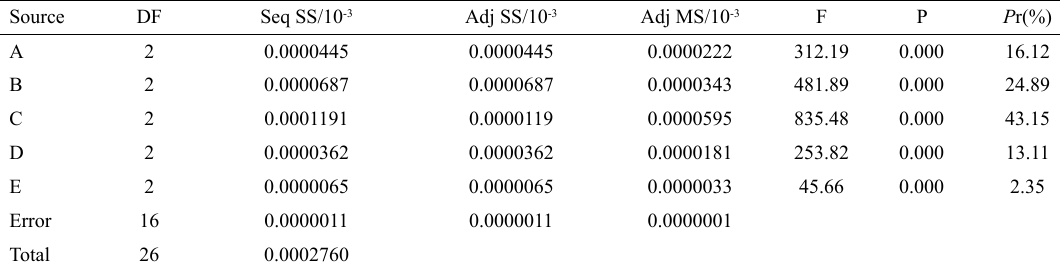
Table 7. ANOVA for wear rate of the hybrid composites Source